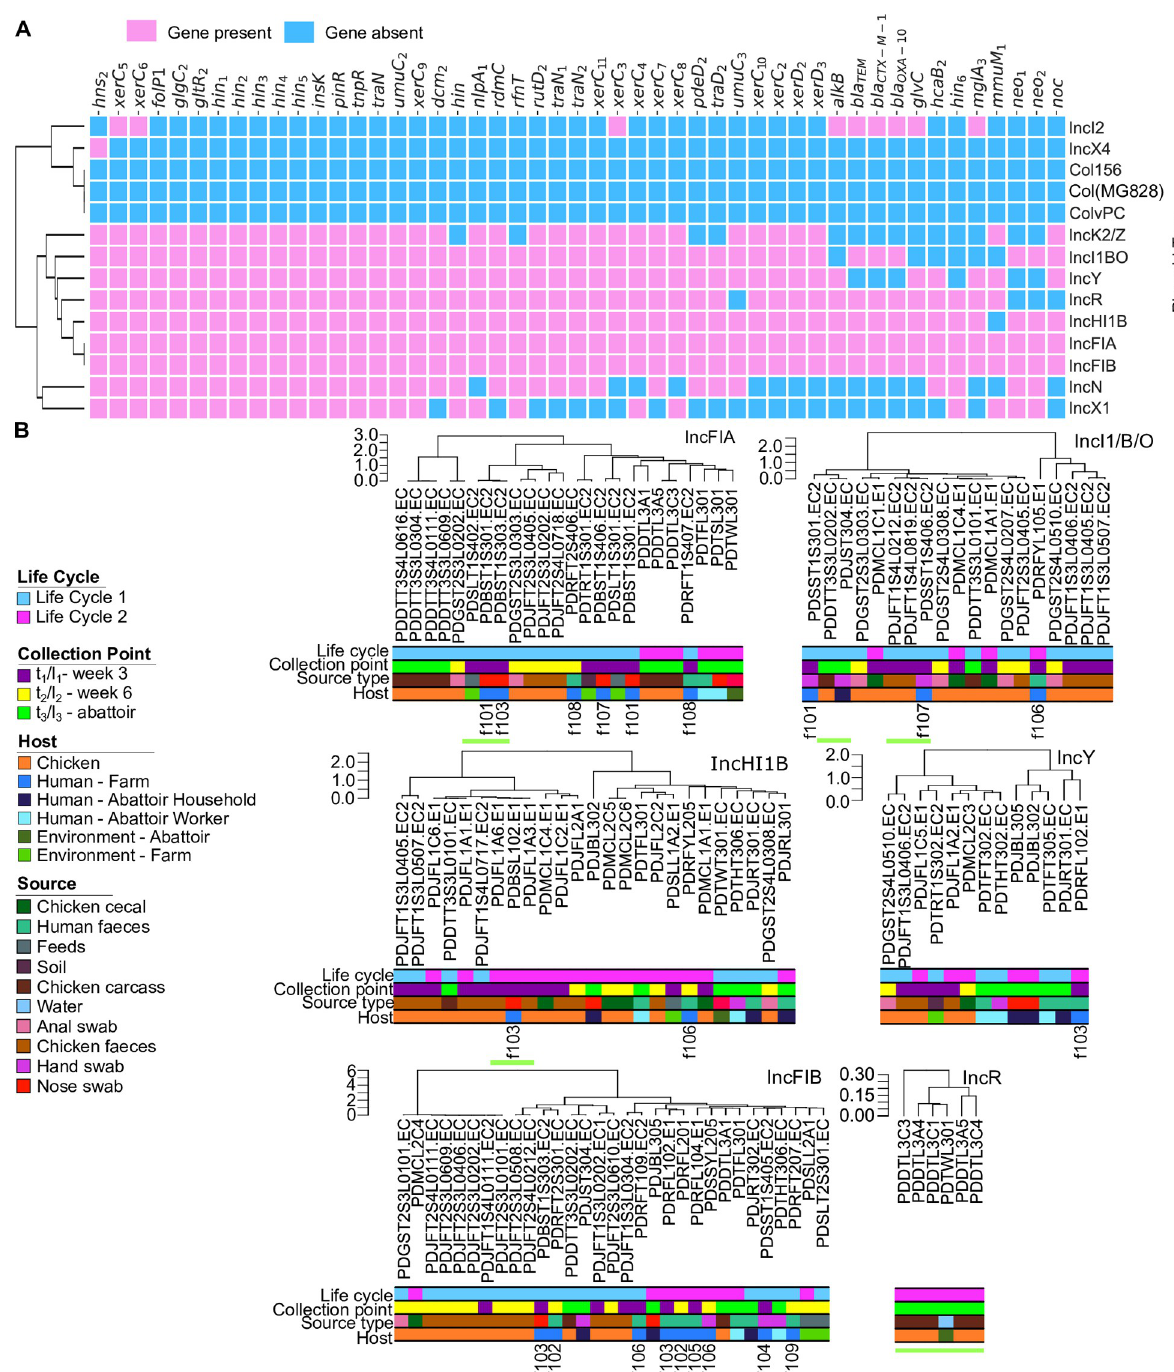
Fig 6. Presence of AMR-associated genes predicted by machine learning in plasmids and hierarchical clustering of isolates based on similarity of plasmid type (A) Heatmap of presence (pink) or absence (blue) of genetic determinants identified by machine learning located on different replicon types of plasmid within the cohort. (B) Hierarchical clustering of isolate plasmid sequences from replicon types with high number of AMR determinants. Clustering was based on gene presence or absence. Green underscores indicate areas of high similarity between isolates from different hosts, suggestive of transmission between